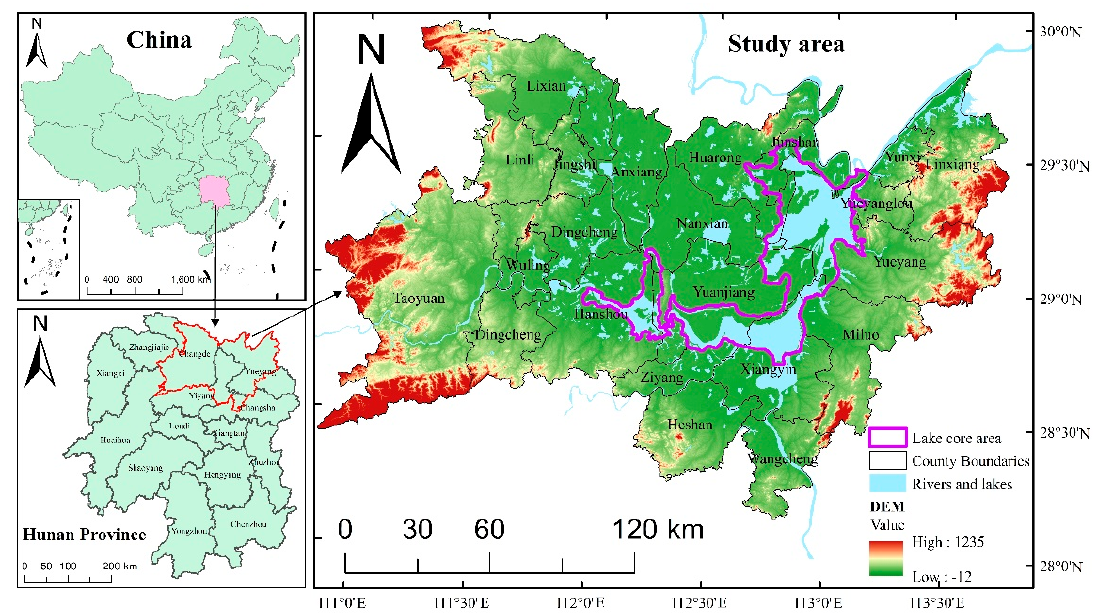
Figure 1. Location and topographic layout of the study area.